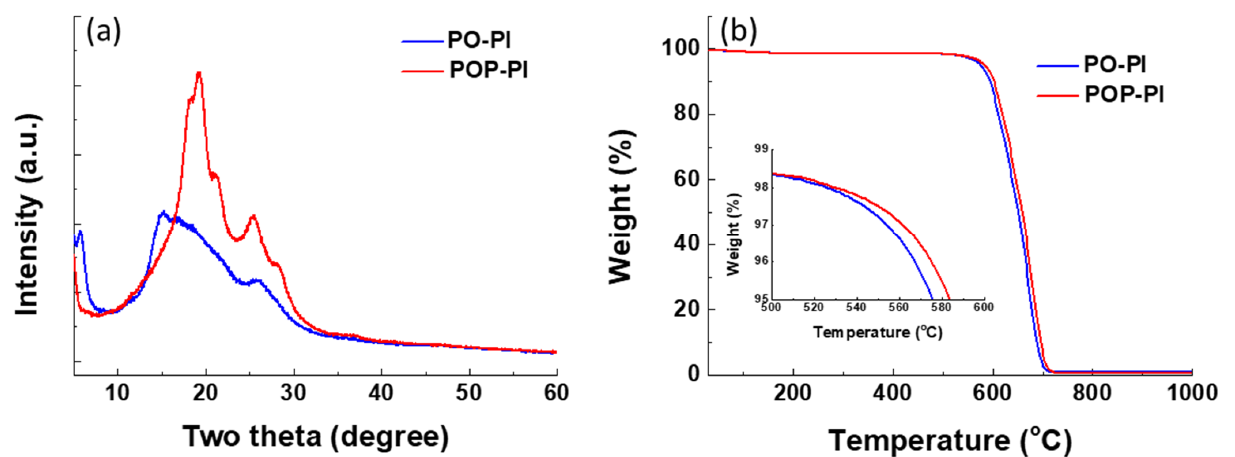
Figure 2. The Fourier transform infrared (FTIR) spectra of ( a ) PO-PAA and POP-PAA and ( b ) PO-PI and POP-PI; the peak deconvolution of the ( c ) O 1s and ( d ) N 1s X-ray photoelectron spectroscopy (XPS) spectra of the as-prepared PO-PI.